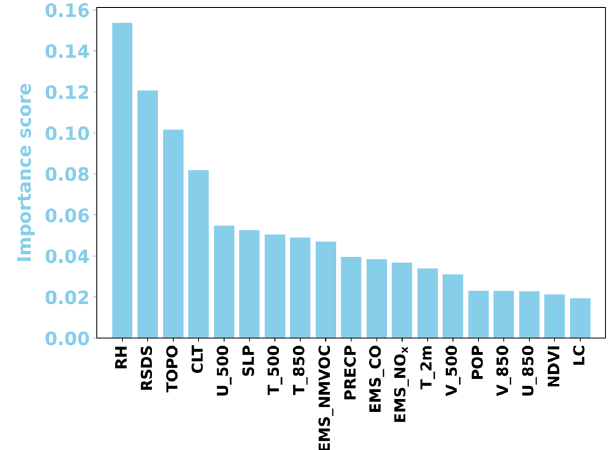
Figure 5. Importance scores of independent variables (meteorolog- ical parameters, emissions, land use, topography, and population density) used in the ML model for predicting future near-surface O 3 concentrations over